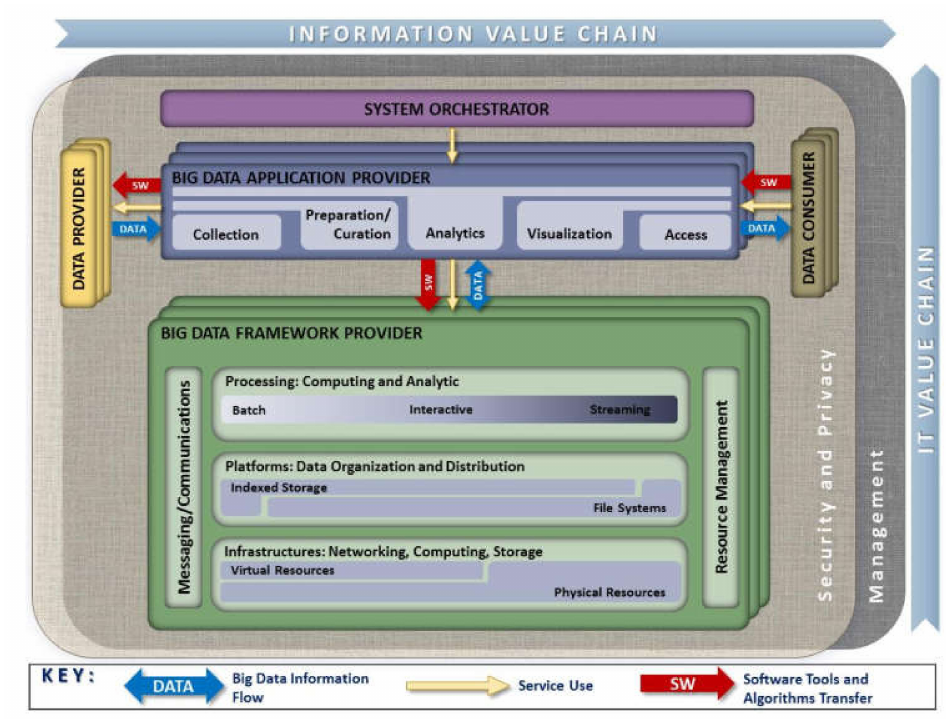
Figure 1. The National Institute of Standards and Technology (NIST) big data reference architecture. Source: Reference